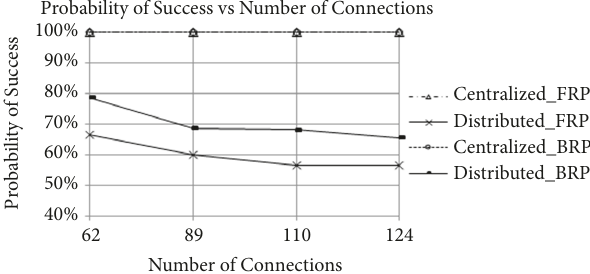
Figure 22: Probability of success for C-NOM and D-NOM using FRP and BRP with parallel arrivals.